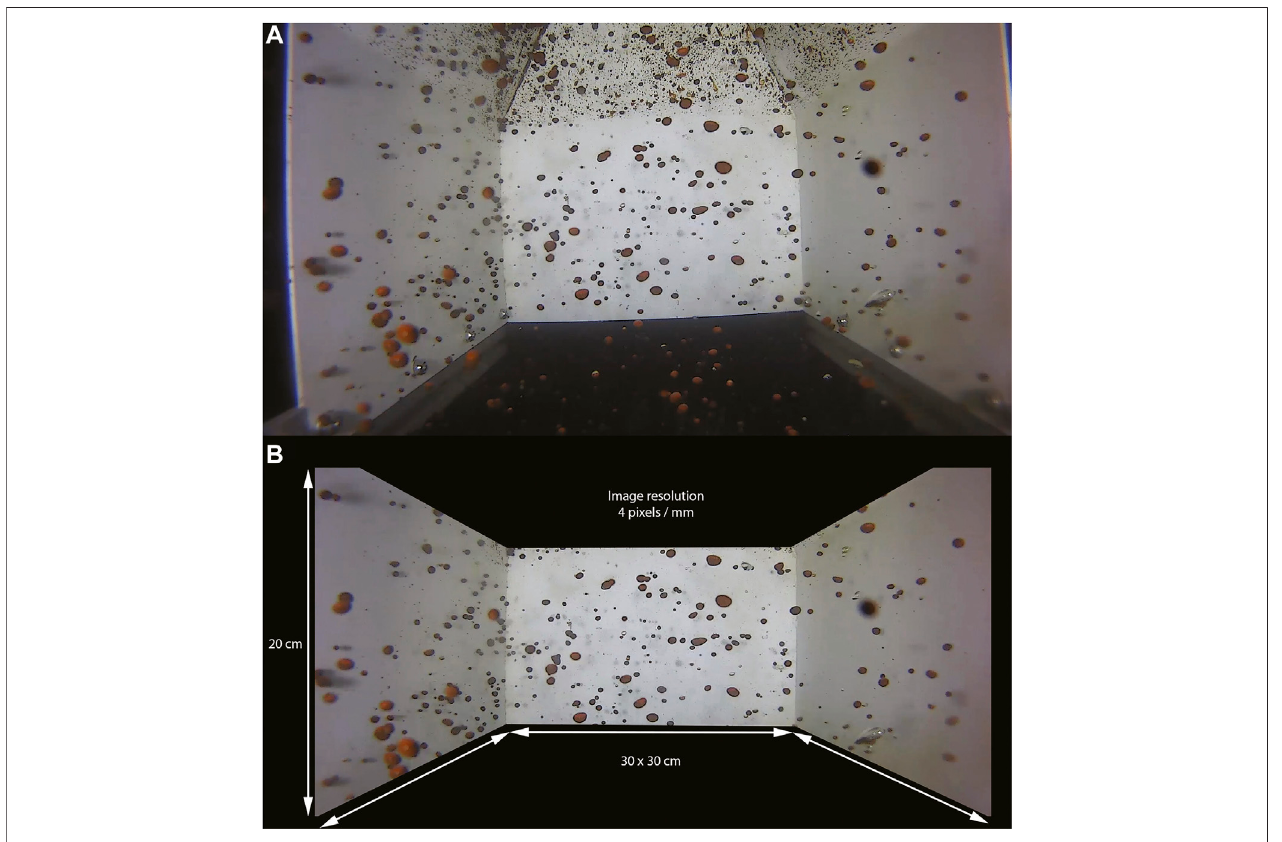
FIGURE 3 | Example of the still images recorded with the bubblometer digital video camera: (A upper) unprocessed frame grab; (B lower) the same image after cropping to remove non-quanti fi ed portions of the image and rotating to correct camera placement, original Fig. 4.2 (Mason et al., 2019).